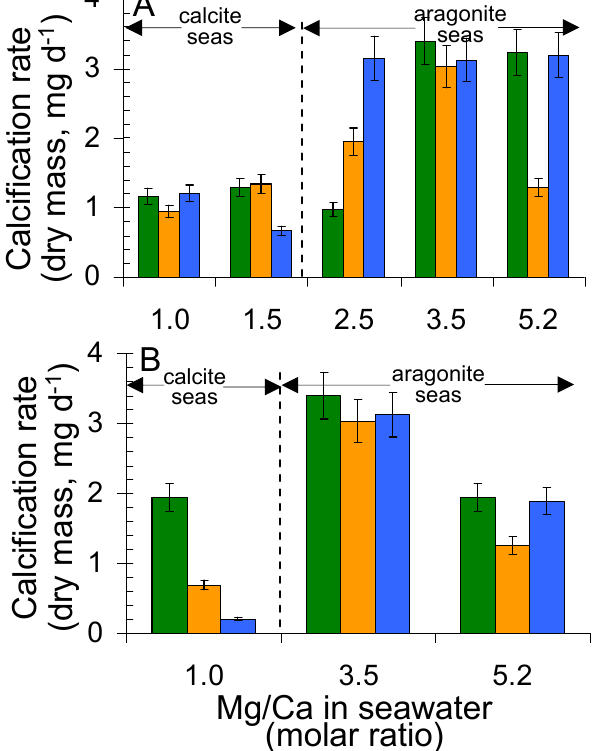
Fig. 19. Calcification rates of Acropora cervicornis (green bars, n =60), Montipora digitata (orange bars, n =60), and Porites cylin- drica (blue bars, n =60) reared in eight chemically unique experi- mental seawater treatments (from Ries et al., 2006). (A) Calcifica- tion rates versus Mg/Ca ratio of experimental seawater. Ca 2 + con- centration of seawater decreases as Mg/Ca increases. (B) Calcifica- tion rates versus Mg/Ca ratio of seawater treatments. Ca 2 + concen- tration held constant at 14.1mmolkg-SW − 1 in all three treatments, to isolate the effect of Mg/Ca ratio on coral growth rates. Error bars correspond to instrument error plus specimen variation. Mg/Ca < 2 = calcite seas; Mg/Ca > 2 = aragonite + high Mg calcite